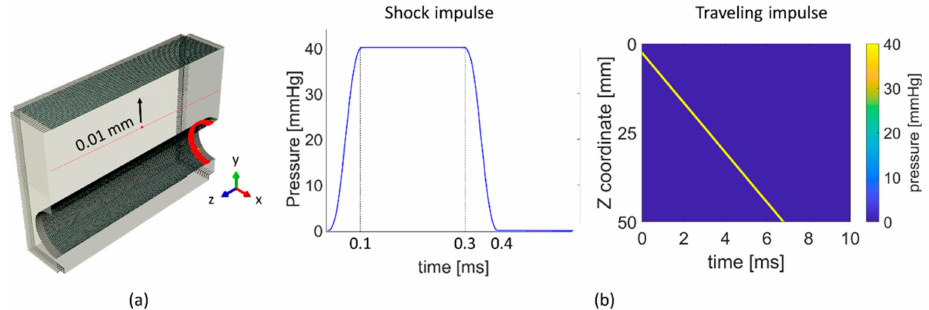
Figure 2. ( a ) Shear wave propagation was induced by a localized displacement of 0.01 mm and the wave propagation was tracked along the adjacent nodes on the red line in the z-direction. The ring-shaped region represents the lumen area where loading conditions of shock impulse and travelling impulse were applied. ( b ) The left panel shows the temporal pressure profile for the shock impulse and the right panel depicts the spatial pressure profile along the length of the model (z direction) of a travelling impulse with velocity V z of 7 m /